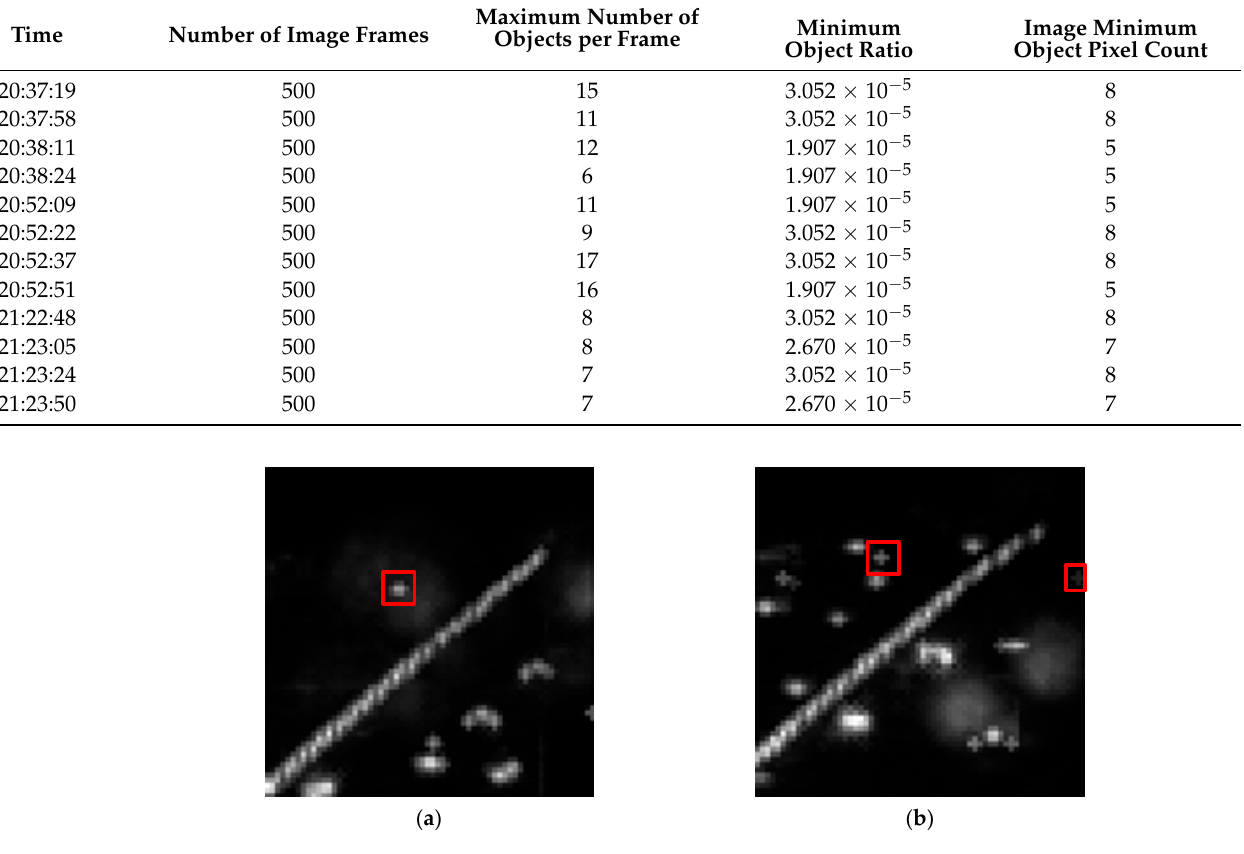
Figure 3. Small object data in the dataset. ( a ) Small objects with a minimum of 8 pixels; ( b ) small objects with a minimum of 5 pixels. Table 1. Night vehicle data details.